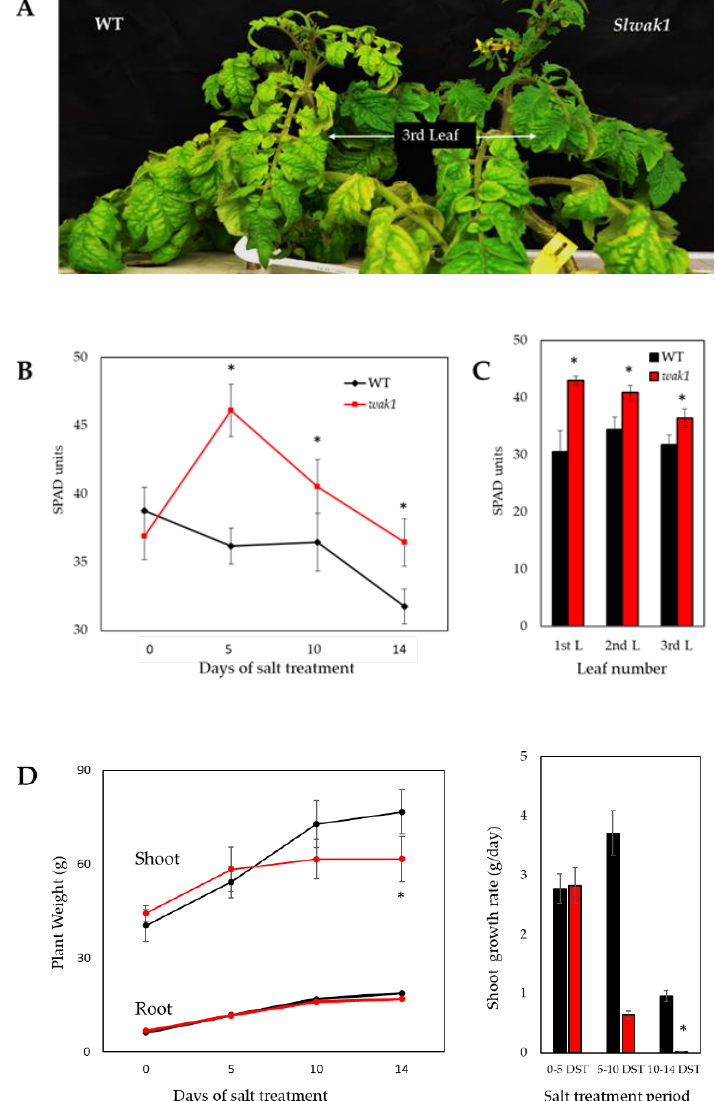
Figure 3. The null Slwak1 mutant shows salt-sensitivity in spite of its lower leaf chlorosis than WT under salt stress. ( A ) Representative images of WT and Slwak1 salt-treated plants (200 mM NaCl for 14 days). ( B ) Temporal evolution of the chlorophylls levels in the third developed leaf of WT and Slwak1 plants. ( C ) Changes in the chlorophylls levels of the first three developed leaves (from the apex) at the end of the experiment. ( D ) Evolution of shoot and root biomass and shoot growth rate during salt treatment period. Data are expressed as mean ± SE ( n = 5). Asterisks indicate significant differences between mean values of WT and Slwak1 (Student’s t -test, p < 0.05).